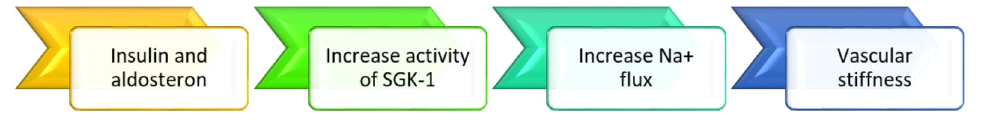
Figure 5. Insulin and aldosterone and the development of vascular stiffness (SGK-1: Serum and glu- cocorticoid kinase 1). glucocorticoid kinase